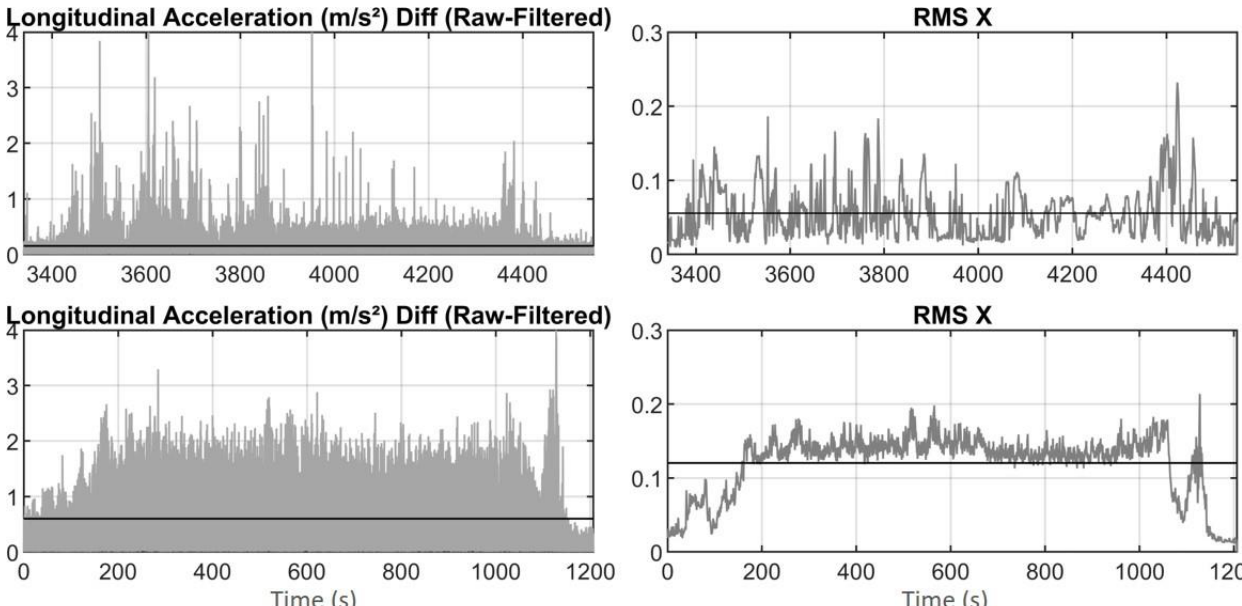
Figure 3. Examples of calculation of vibrations on longitudinal acceleration—ambulance trip ( top ), Figure 3 . Examples of calculation of vibrations on longitudinal acceleration — ambulance trip ( top ), helicopter trip ( bottom helicopter trip ( bottom ) .